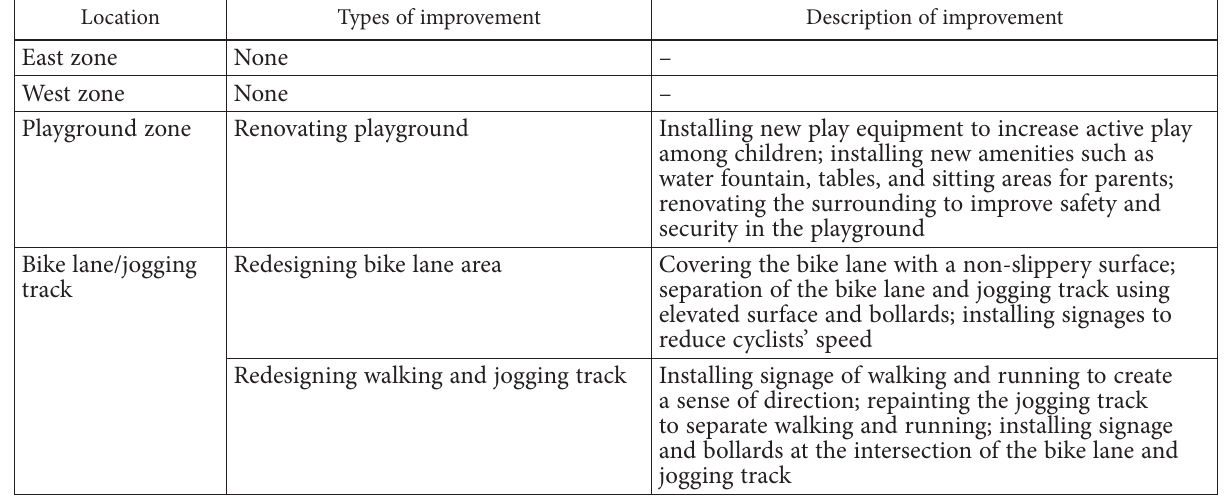
Table 1. Summary of park improvement conducted for the study